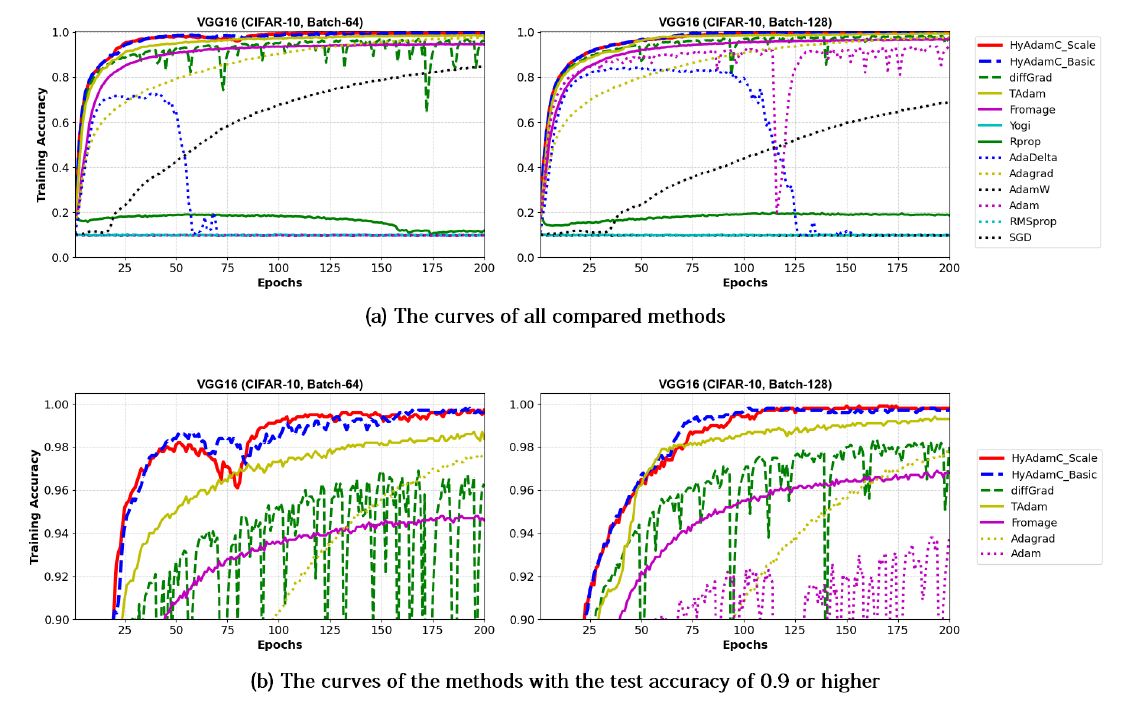
Figure 13. The training accuracy curves of the VGG-16 trained by HyAdamC and other optimization methods in the CIFAR-10 image classification tasks. In this figure, ( a ) shows the training accuracy curves of all compared methods. On the other hand, ( b ) illustrates the plots in which a range of the y-axis of the plots described in ( a ) is zoomed into between 0.9 and 1.